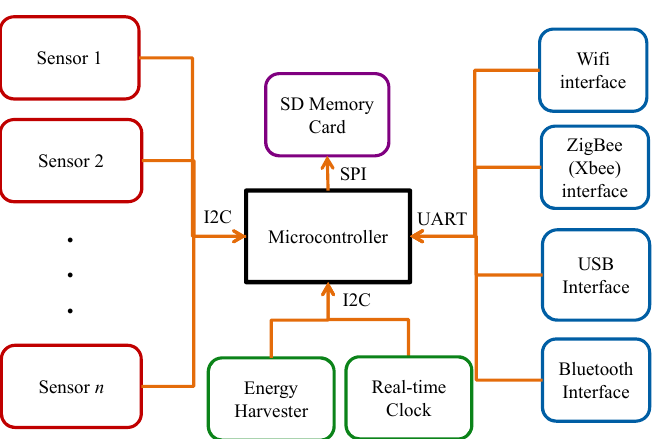
Figure 1. Monitoring device